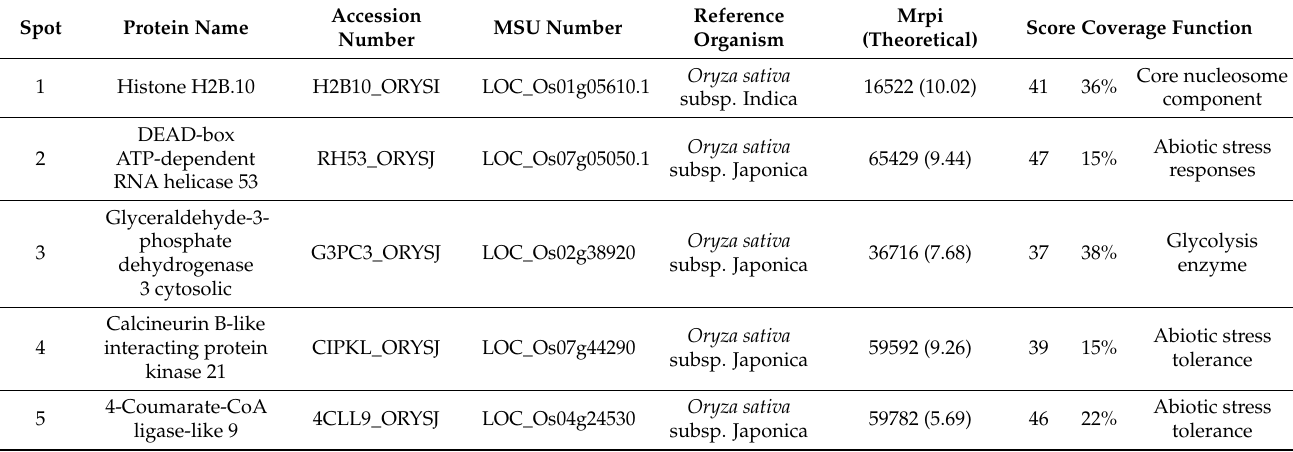
Figure 3. Two-dimensional gel electrophoretic analysis of the protein profiles of rice root proteome under control condition ( A ) IR64 root ( B ) Luna Suvarna (LS) root. Table 1. Specifically expressed proteins in Luna Suvarna (LS) versus IR64 roots identified using MALDI-ToF/ToF mass